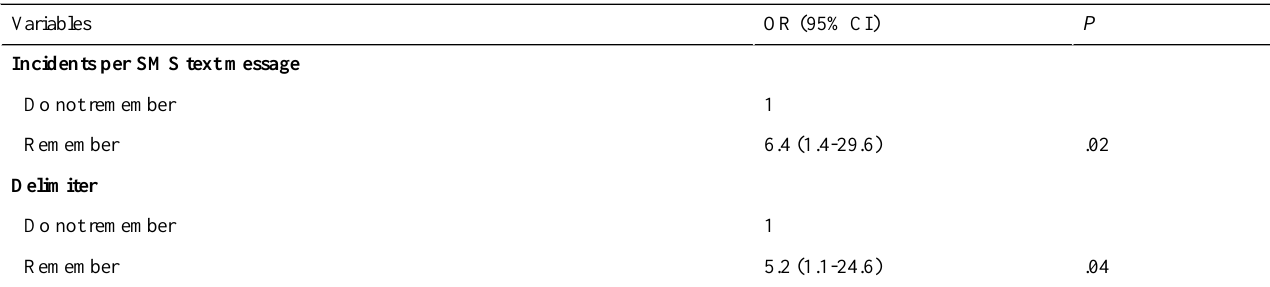
Table 7. Multivariate logistic regression model to study the impact on the possibility of reporting all 28 diseases asked for by the MOH of different components of the SMS text message